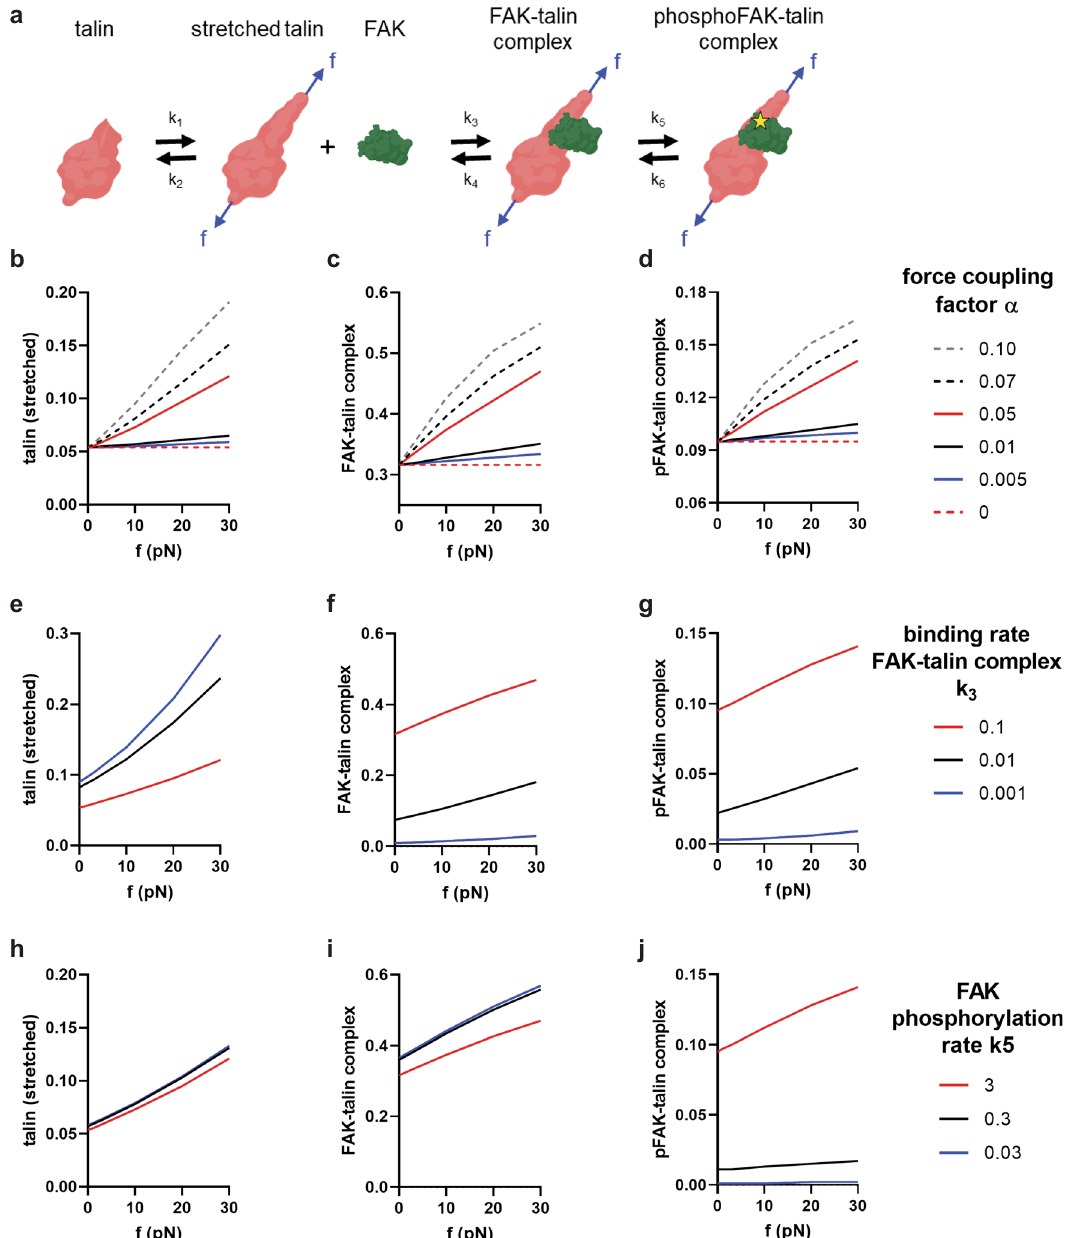
Fig. 6 Kinetic model of talin-FAK interactions under force. a Schematic of FAK-talin interactions showing unstretched ( T ) and stretched talin ( T st ), free FAK ( F ), FAK-talin complex ( FT st ), and phosphorylated FAK-talin complex ( pFT st ). Governing equations and parameters used in the kinetic model are listed in Supplementary Materials. b – d Solutions for a relative number of ( b ) stretched talin, ( c ) FAK-talin complexes, and ( d ) phosphorylated FAK-talin complexes as a function of applied force (f) for different values of the force coupling factor ( α ). e – g Solutions for a relative number of ( e ) stretched talin, ( f ) FAK-talin complexes, and ( g ) phosphorylated FAK-talin complexes as a function of applied force (f) for different values of the forward binding rate constant for FAK-talin complex ( k 3 ). h – j Solutions for a relative number of ( h ) stretched talin, ( i ) FAK-talin complexes, and ( j ) phosphorylated FAK-talin complexes as a function of applied force (f) for different values of the FAK phosphorylation rate constant ( k 5